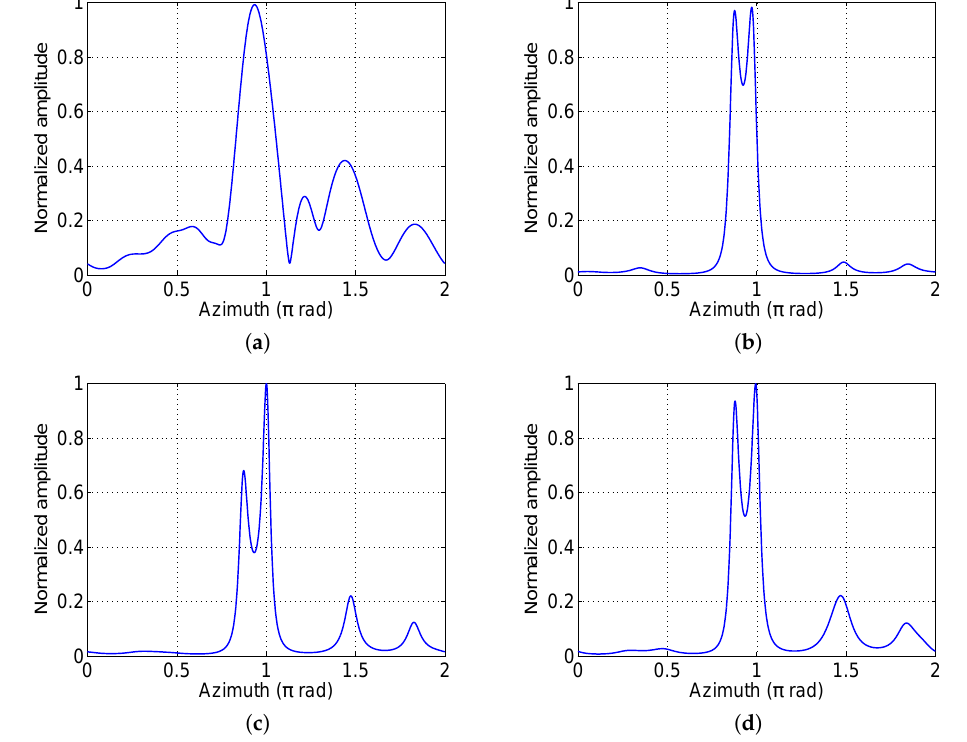
Figure 9. Azimuthal profiles of two corner reflectors using different imaging methods. The distance between the two targets was 0.39 m—half of the Rayleigh limit of the circular array. ( a ) Fourier method; ( b ) Covariance method; ( c ) Modified covariance method; ( d ) Burg